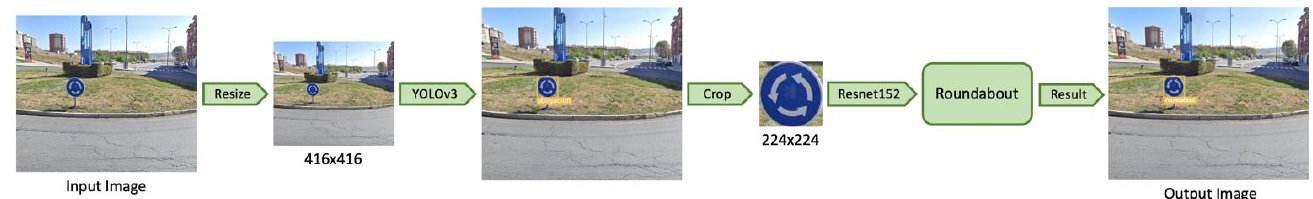
Figure 3. Workflow of the DL block, from an input image traffic signs are detected and hierarchically classified.